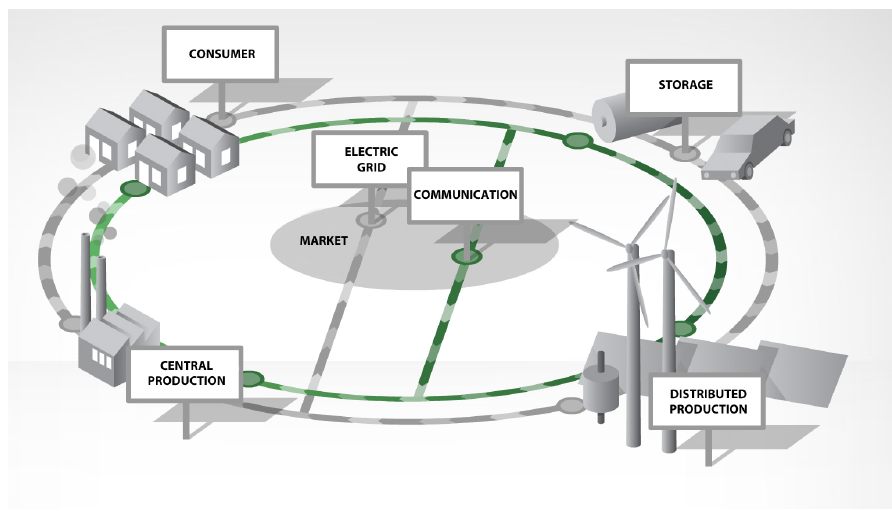
Figure 1. The Smart Grid: Services based on Information and Communication Technology (ICT) are added to the established energy management paradigm to support efficient grid control in the presence of distributed energy resources